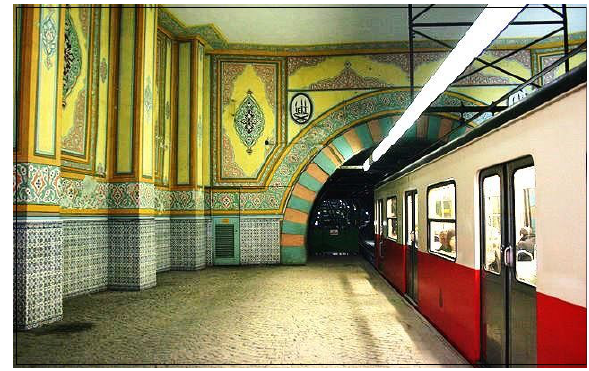
Figure 4. Karaköy station of Istambul metro [3] In 1910, the line was electrified and between 1968 and 1971 it was significantly modernised. The line has been incorporated into the Istanbul at-grade trans- portation system. It links to a common tramway track at the boarding station (itself linking to the Karaköy port); the disembarking station links to the historic tramway track (transfer to Line M2 of the classical metro being also possible). The line carries a daily average of 15,000